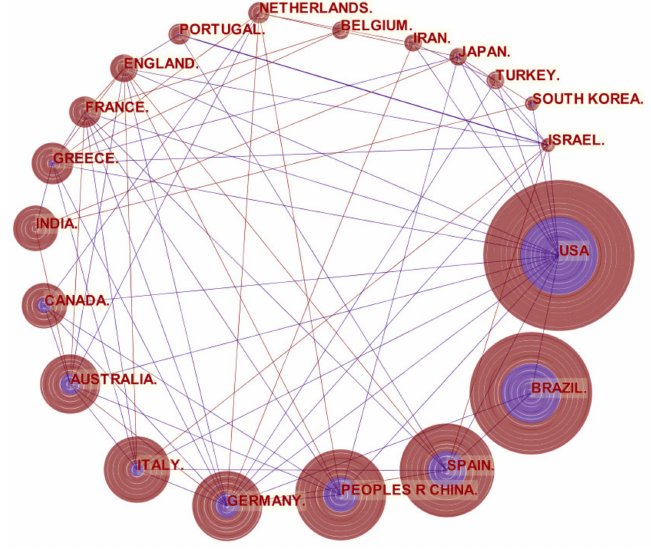
Figure 18. Cooperation matrix of the top 20 countries/regions with the highest productivity (circle size represents the number of citations).